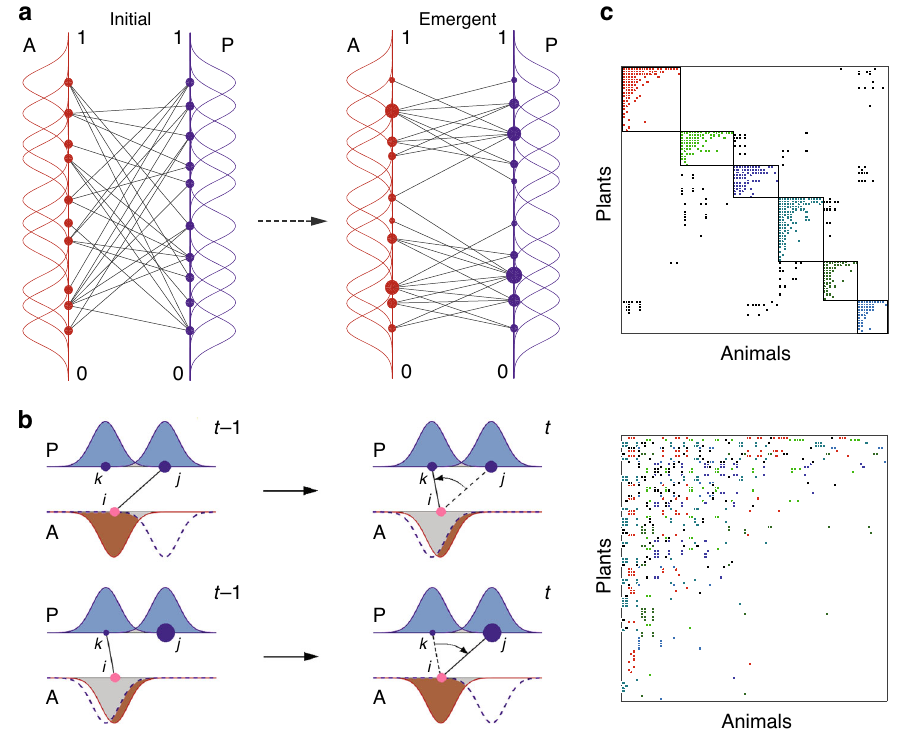
Fig. 1 Pattern formation from adaptive niche-based interactions. a Adaptation of niche relation and demographic distribution. An example network of 20 species in mutually interacting guilds (A and P) develops from a random relation (left) to a stable partnership (right). Each species i possesses a pair of characteristics: a niche pro fi le (Gaussian function H i ( s )) randomly scattered on the niche axis, and an individual species abundance (represented by a disk of proportional size). The species abundances are governed by the generalized Lotka-Volterra dynamics (Eq. 5a, Eq. 5b), where the coupling strengths are determined by the proximity of interacting speci fi c niches across the guilds for mutualism and within the guilds for competition. b Rewiring and updating niche proximity. A species rewires to a randomly selected new partner species with updated niche proximity. The rewiring is accepted if the individual species abundance increases and rejected otherwise. The example in the upper panel demonstrates the rewiring of a node i from a partner j with a slightly higher abundance to a new one k with a larger niche proximity, H ij → H ik . In contrast, the lower panel shows that a node rewires to a new partner with a smaller niche proximity but a signi fi cantly higher abundance. The gray area represents the niche proximity. c Network patterns in steady state. An assembled network is shown for example, with 100 species in each guild, simulated for C 0 = 0.058 and ( Ω m , Ω c ) = (0.10, 0.05), with signi fi cantly higher nestedness and modularity (NODF = 0.1666, Q = 0.6207) than the randomized networks ( P ≤ 0.0001; two-sided t test). The adjacency matrix is reordered to express the modular (upper panel) and nested (lower panel) patterns of the same network, with the colors indicating the module